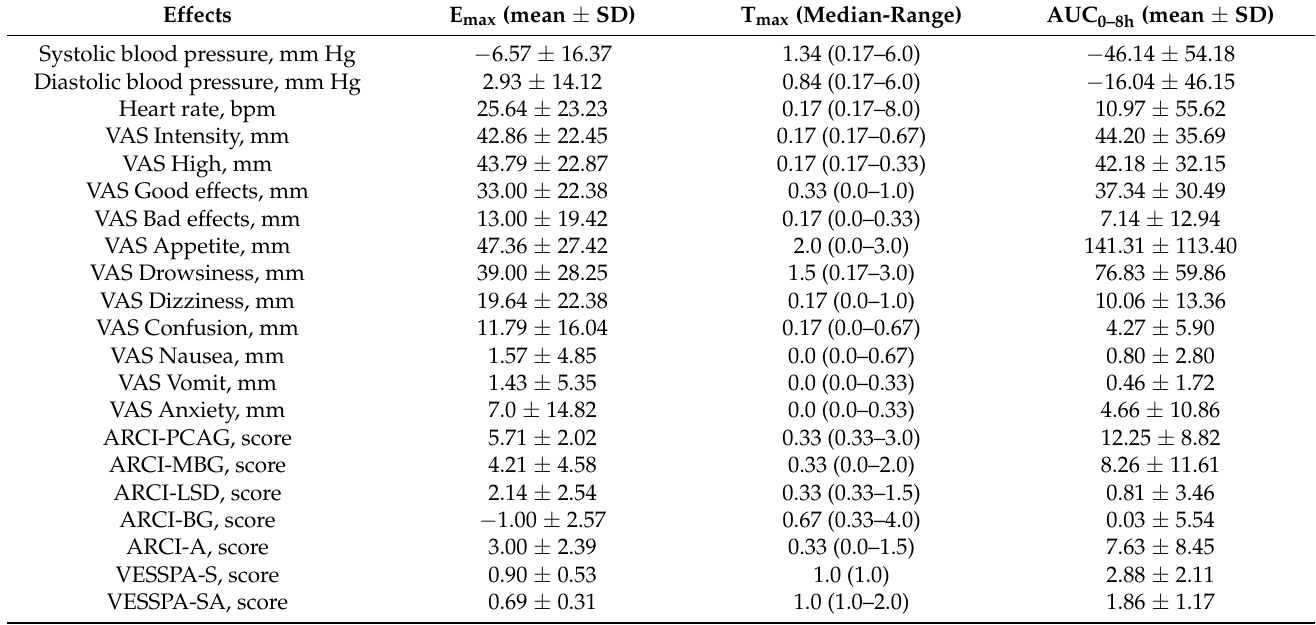
Table 3. Physiological and subjective effects in healthy volunteers administered with 100 mg vaporized medical